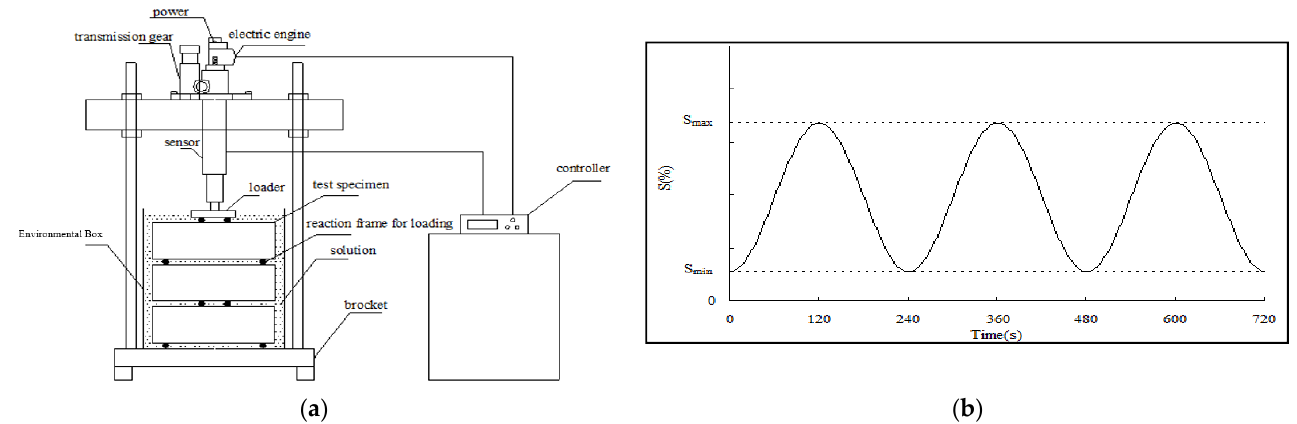
Figure 2. Schematic diagram and loading spectrum of the attack test device. ( a ) Schematic diagram; ( b ) loading spectrum.